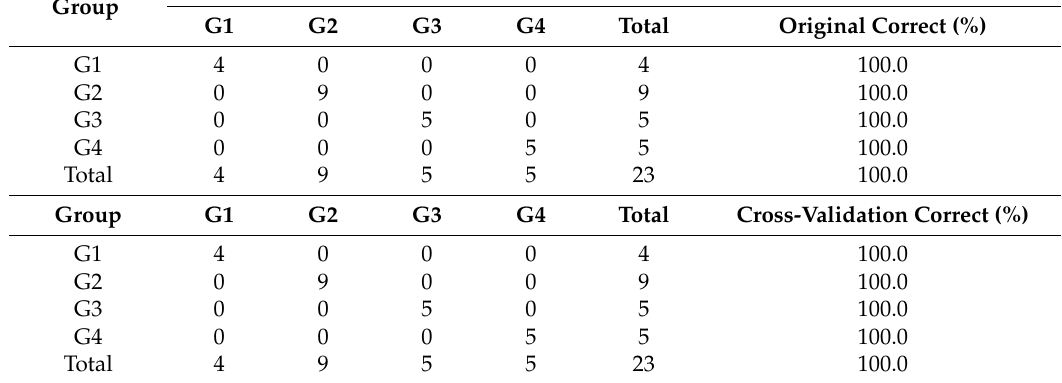
Table 4. Observations of the original and cross-validation results together with the classification of P. tenuifolia samples using the discriminant analysis